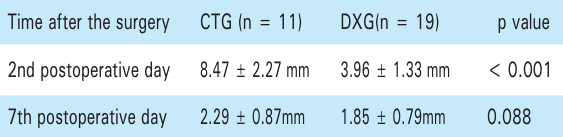
Table 2. Comparison of facial oedema among